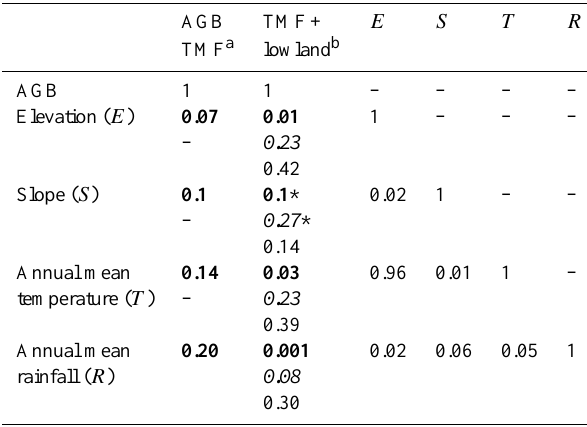
Table 2. Correlation ( r 2 ) of above-ground biomass (AGB) with to- pographical and meteorological variables. Correlations are shown separately for all sites (bold), neotropics (italics) and Asia (normal text) for the subset of sites where data on elevation, slope, tem- perature and rainfall are all available. Asterisks indicate significant ( P < 0 . 01)